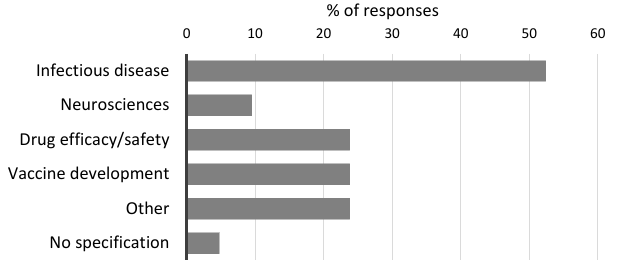
Figure 2. Frequency of experienced influence of genetic variation in major biomedical disciplines ( N = 21).